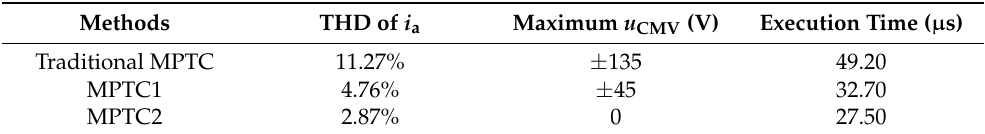
Table 5. Comparisons of different